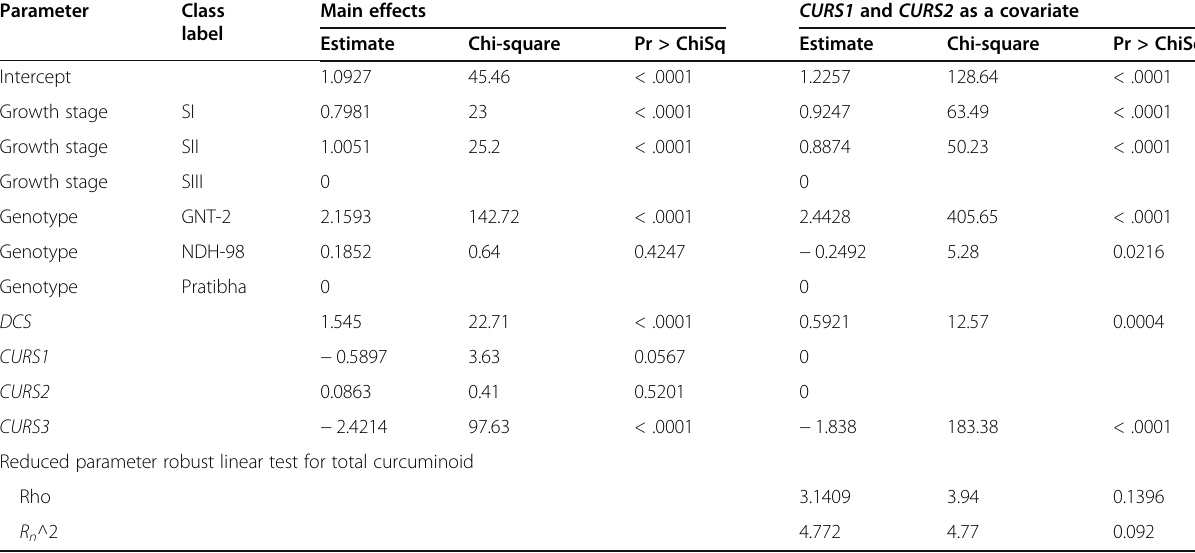
Table 6 Association-based test of DCS and multiple curcumin synthases with total curcuminoid